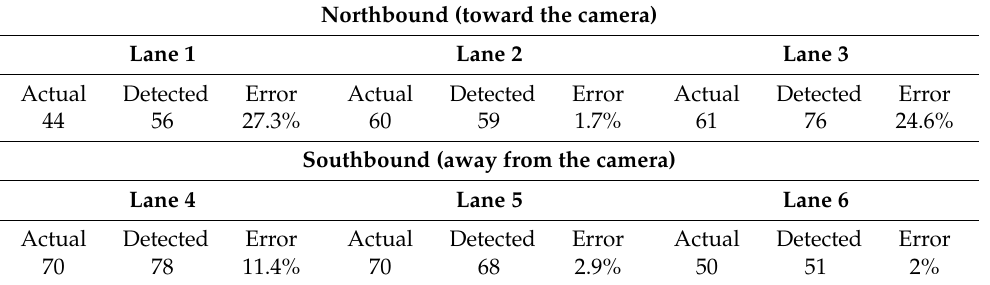
Table 3. Vehicle counting results (in three